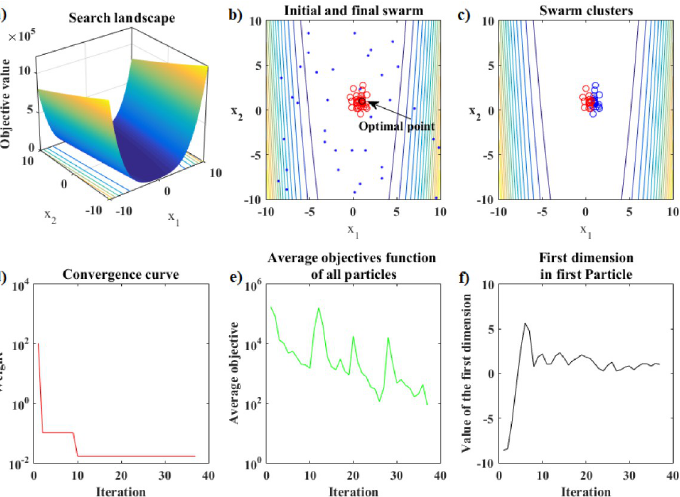
Fig 9. Rosenbrock function. Details of the hybrid optimization process in phase 1 for the stopping criterion based on the relationship between the standard deviations of the objective function values.